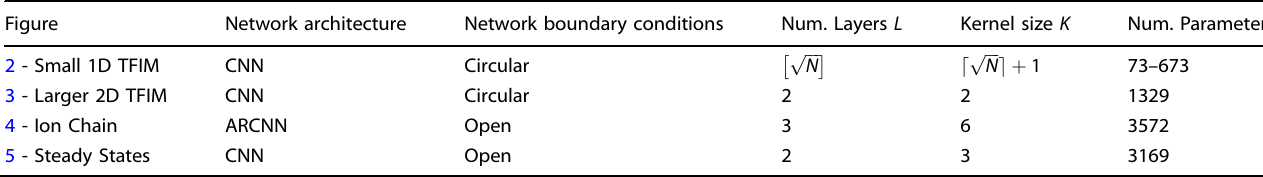
Published in partnership with The University of New South